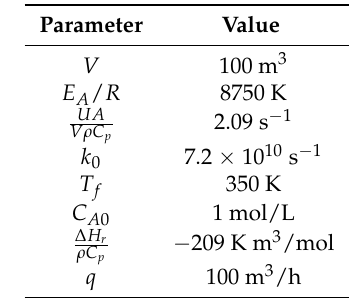
Table 5. Reactor parameter